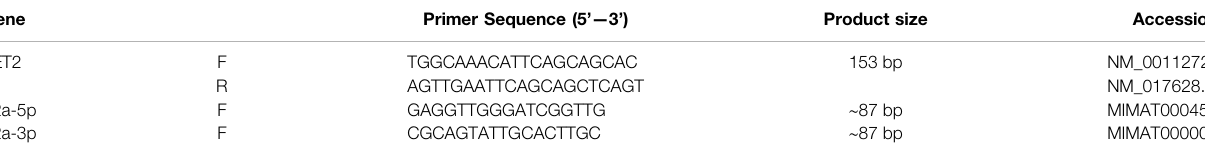
TABLE 3 | Gene expression forward and reverse primer sequences with transcript accession numbers. miRNA expression assays utilised miScript universal reverse primer (Qiagen). Gene